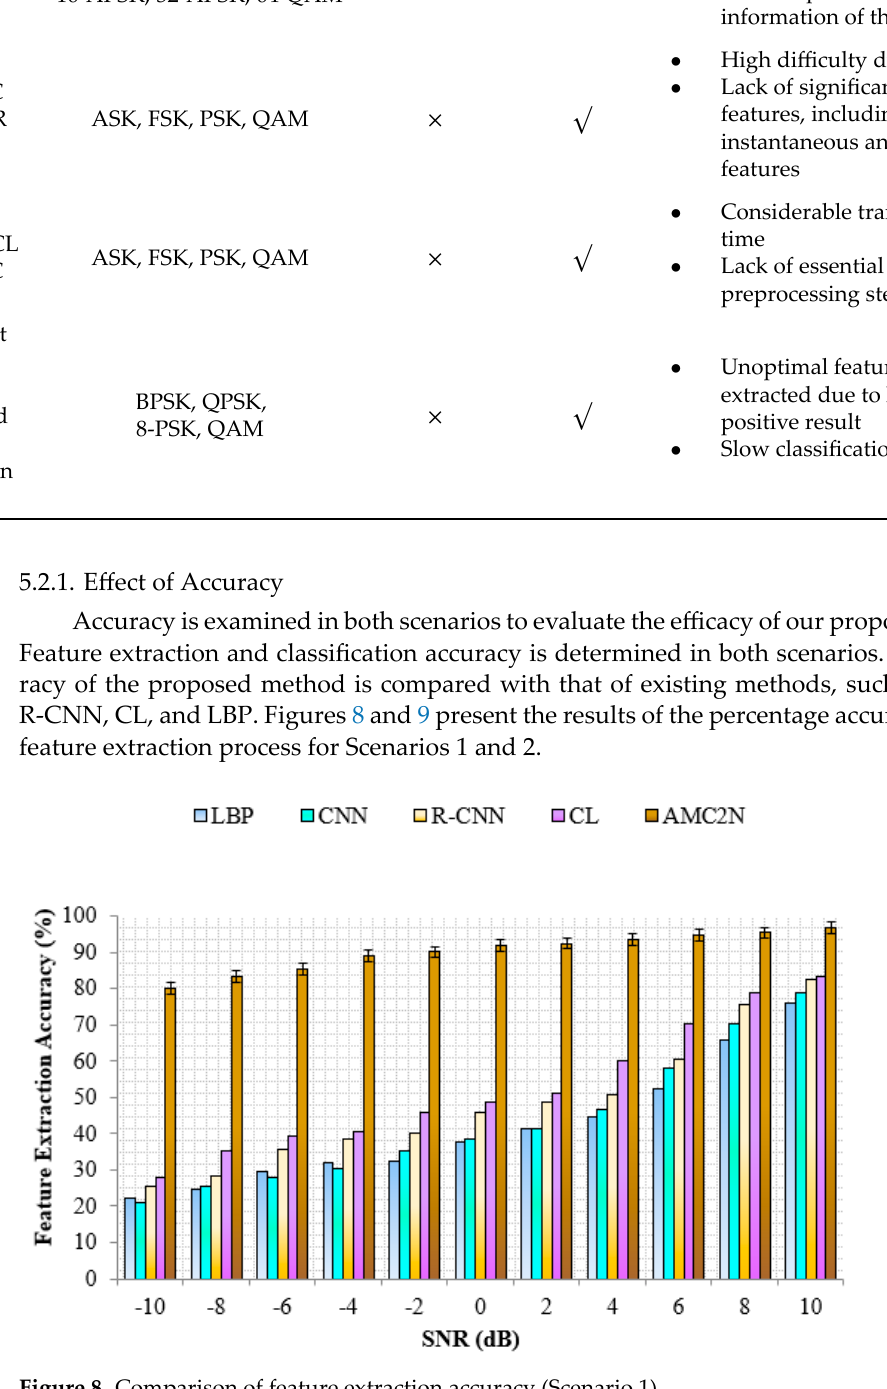
Figure 8. Comparison of feature extraction accuracy (Scenario 1).